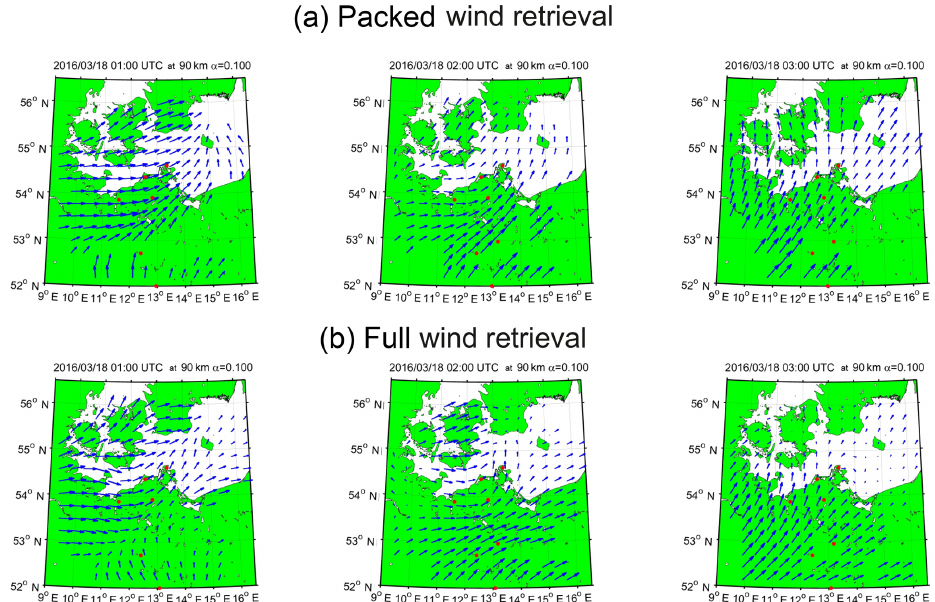
Figure 7. Comparison of wind retrievals. Panel (a) shows the solutions of the “packed wind retrieval”. Panel (b) shows the same time and altitudes for the “full wind retrieval”.